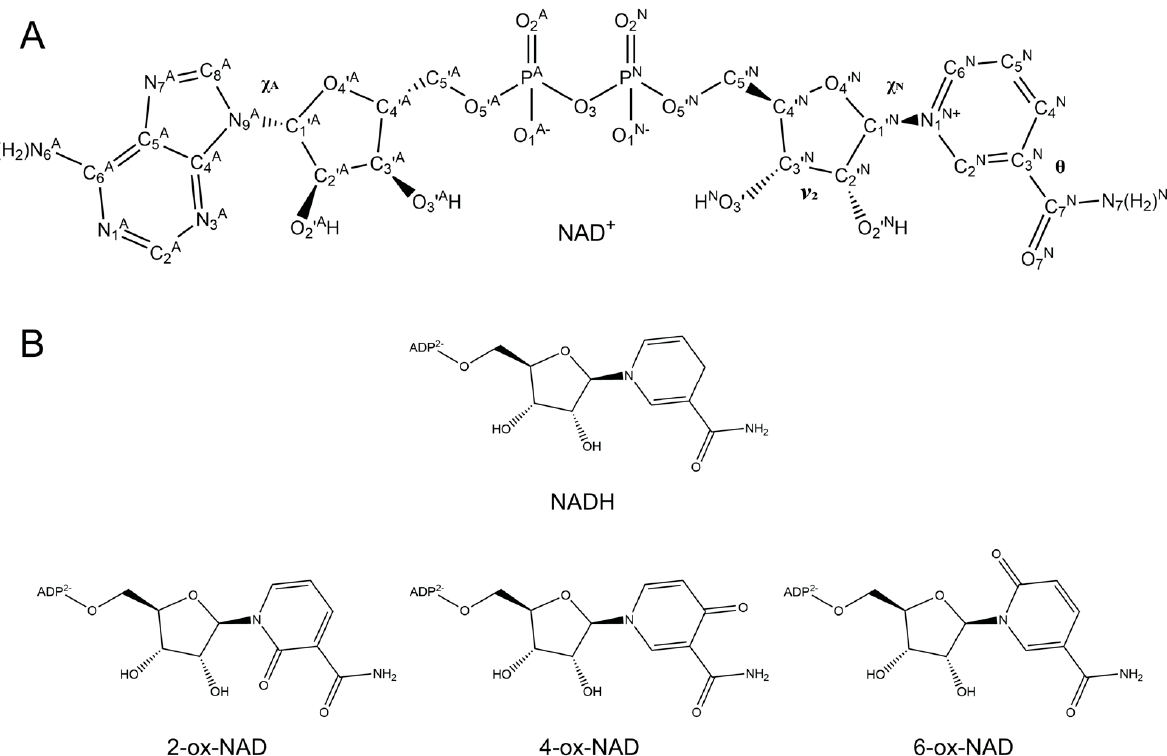
Figure 1. Chemical structures of NAD + , NADH, and ox-NADs. ( A ) NAD + with atom labels indicated. Selected dihedral angles are noted. ( B ) Structures of NADH and ox-NADs. Adenosine diphosphate is simplified as ADP 2 − .